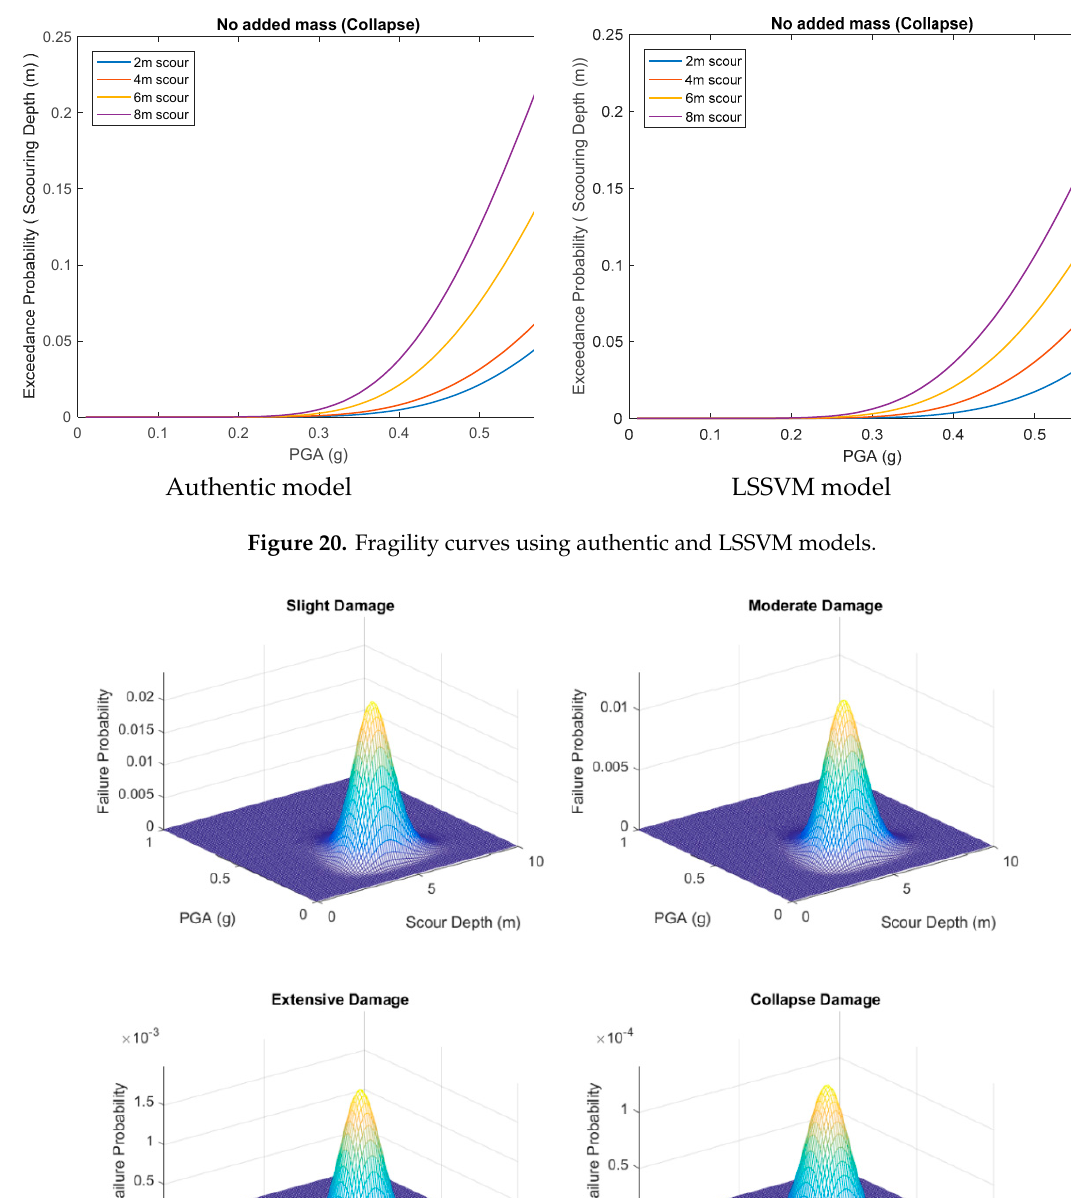
Figure 19. Fragility curves of each scoring depth under the same water level and same performance level using LSSVM.